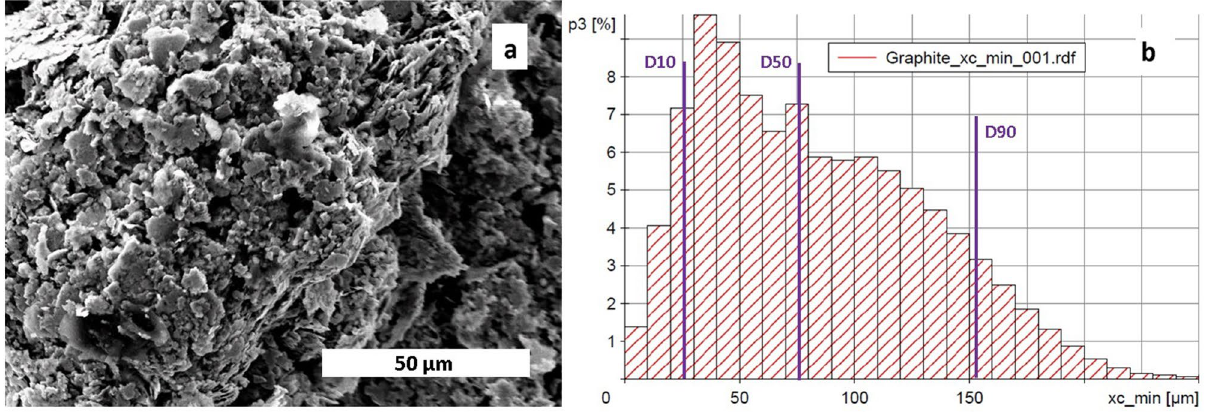
Figure 3. ( a ) Scanning electron microscopy (SEM) image showing graphite powder morphology and ( b ) Particle size distribution of the graphite powder